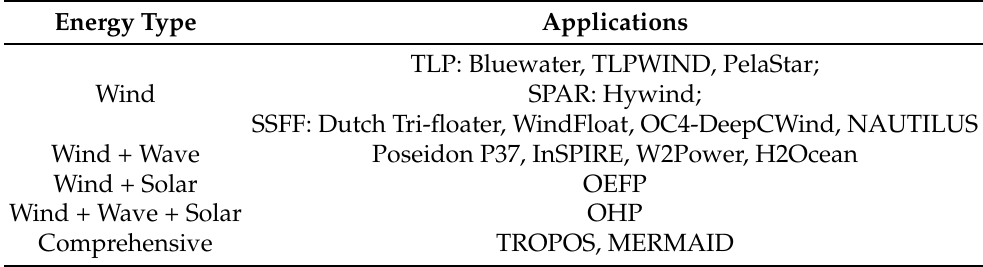
Table 1. The synthesis of floating solutions for offshore